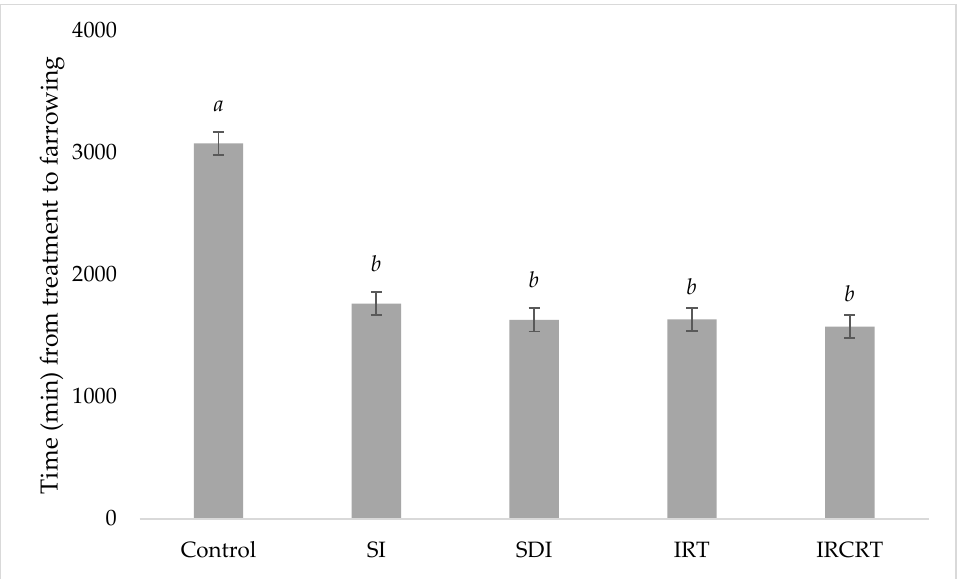
Figure 11. Time taken (minutes) for sows to farrow from time of treatment application to birth of the first piglet. The sows were assigned to five groups. Group 1 (SI) received a single vulval injection of cloprostenol at 0700 h ( n = 32), group 2 (SDI) received the same dose split in two parts, at 0700 and 1300 h ( n = 33). Group 3 (IRT) animals were administered an IR tablet at 0700 h ( n = 32), while group 4 (IRCRT) received both IR and CR tablets at 0700 h ( n = 33). Group 5 was untreated and served as a control ( n = 32). Formulations with significant differences in mean detachment force (at the 95% level of confidence; p -value < 0.05) are represented by different superscripts ( a, b or c ).